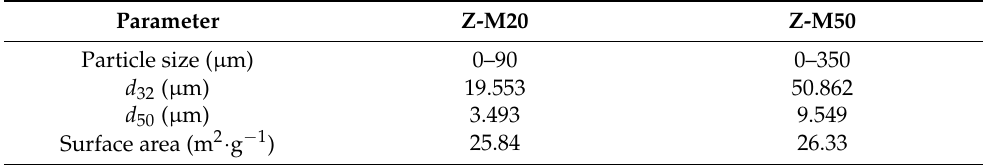
Table 1. The basic physical properties of zeolites.